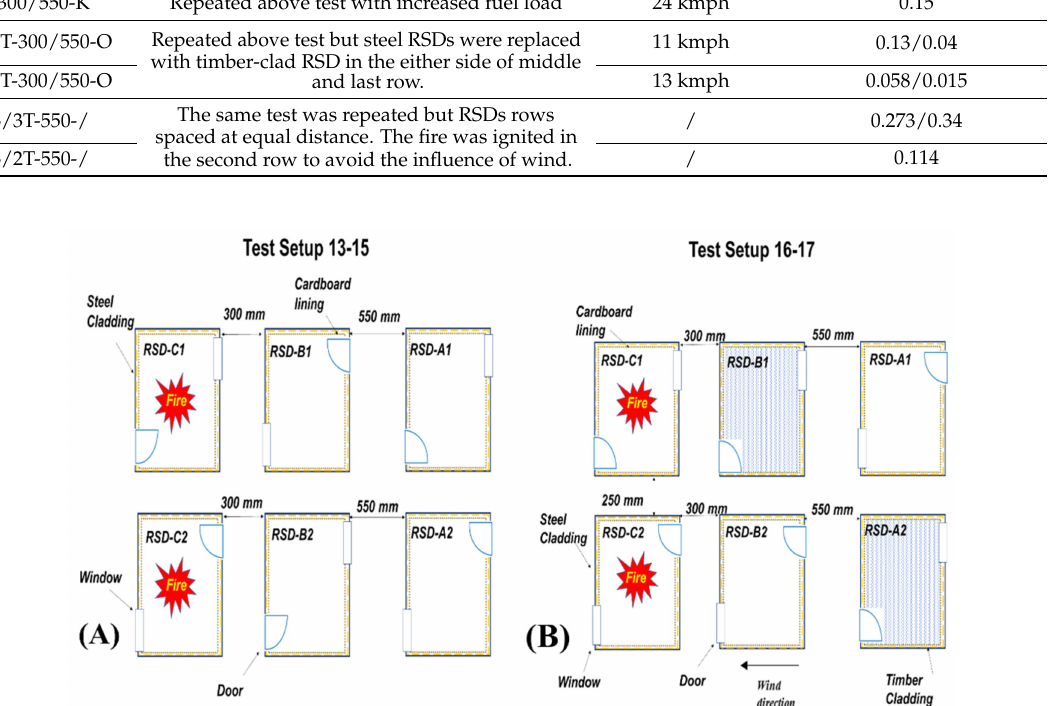
Figure 14. Six RSD experiment—( A ) test setup 13–15, ( B ) test setup